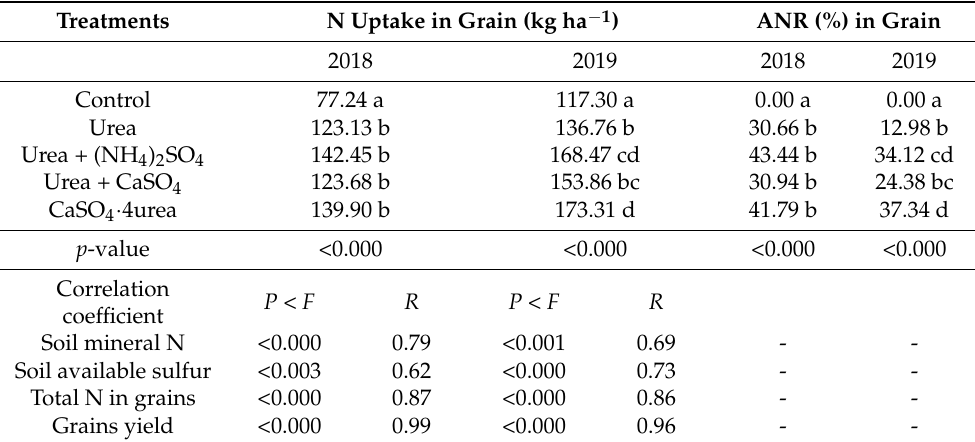
Table 6. Analysis of variance for grain N uptake and ANR including a summary of relationships between these variables in 2 years